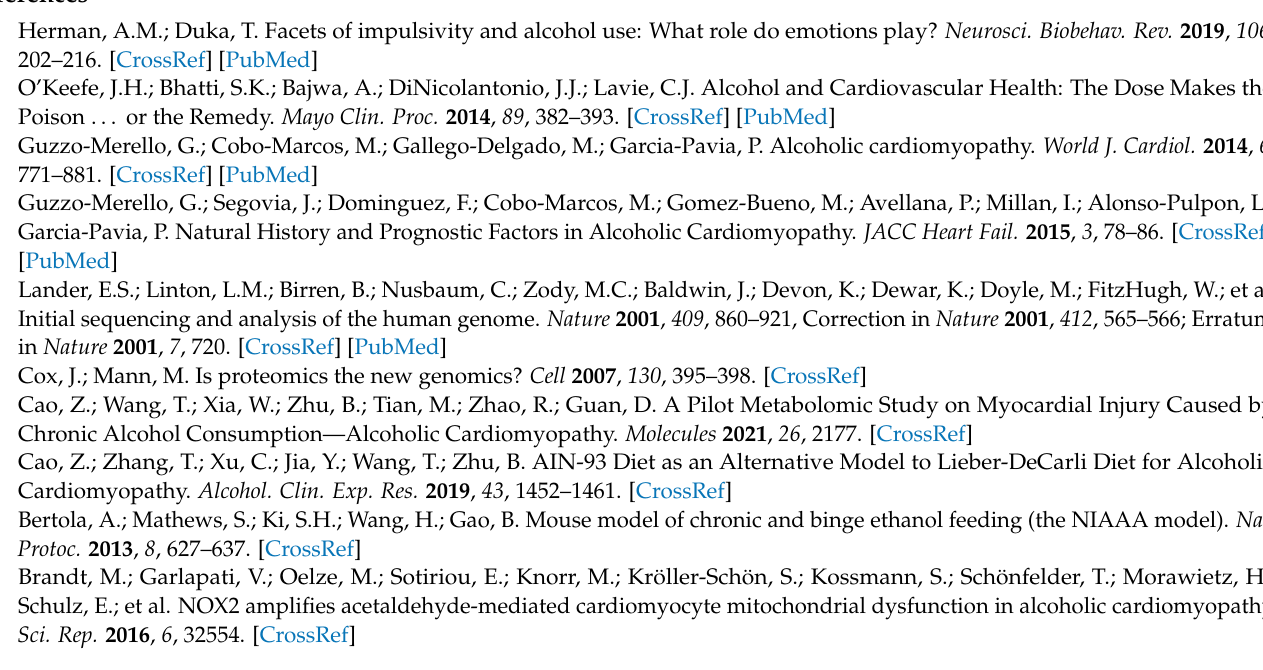
liquid chromatography elution gradient table; Table S2: Liquid chromatography elution gradient table; Table S3: The analysis parameter of Proteome Discoverer 2.4; Table S4: The primer sequences from